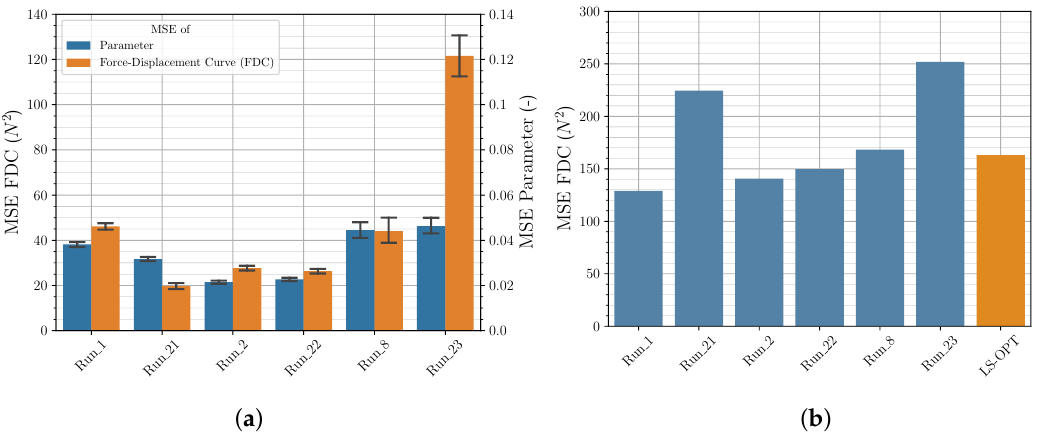
Figure 12. Comparison of MSE of material parameter and FDC from ( a ) validation data and ( b ) experimental data with noisy training data.